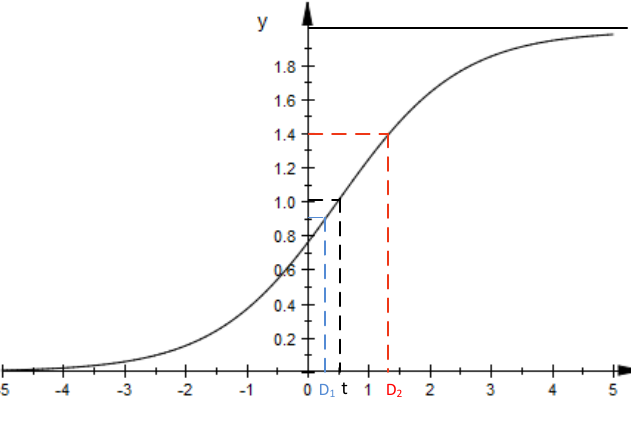
Figure 1. Representation of the revised sigmoid function.